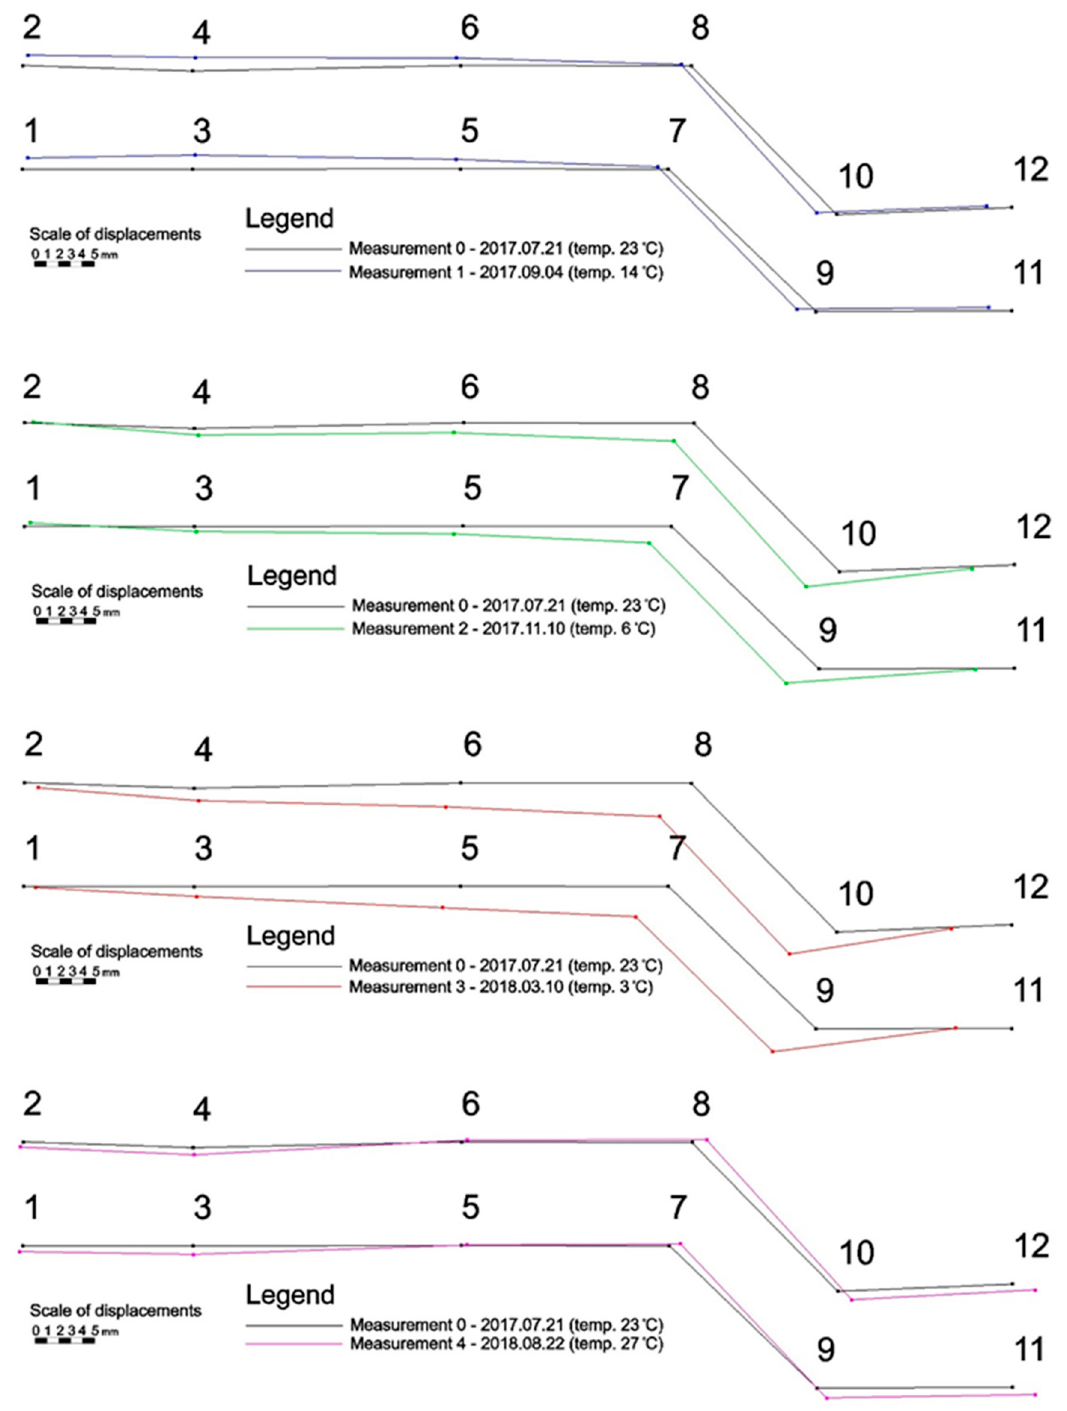
Figure 8. Horizontal displacements of top control points in the flooring of overhead part of